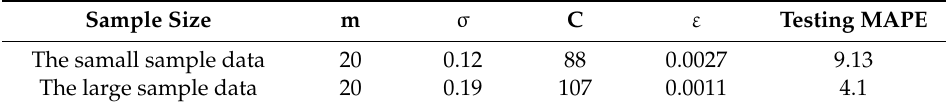
Table 2. The SVR’s parameters for Data-I.